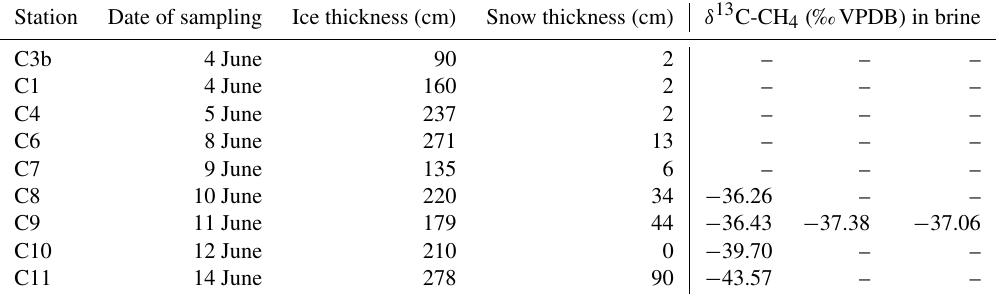
Table 1. Characteristics of the ice stations showing the information about the stations name, date of sampling during the ice drift in 2017, the ice thickness, snow thickness, and the stable carbon isotopic signature of methane ( δ 13 C-CH 4 ) values in brine sampled following the “sackhole” method (e.g., Gleitz et al., 1995). Brine samples were taken at stations C8, C10, C11 (one sample per station), and C9 (three